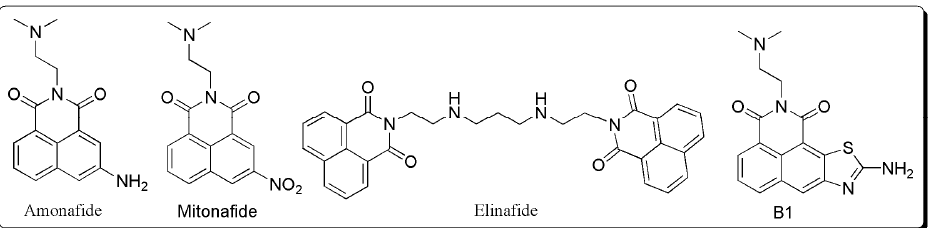
Figure 1. The structures of amonafide, mitonafide, elinafide and B1 .